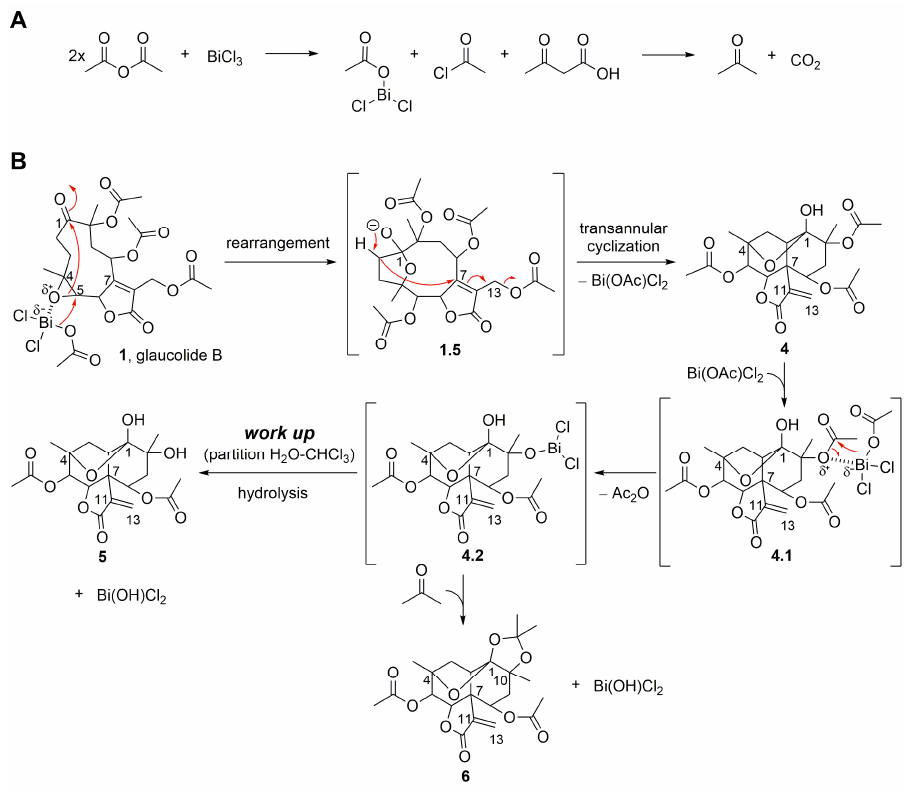
Figure 4. Proposed mechanism for the formation of SL semisynthetic derivatives 4 – 6 involving acetone formation ( A ) and SL-BiCl 3 complexation ( B ) (red arrows illustrate the arrow-pushing mechanism).